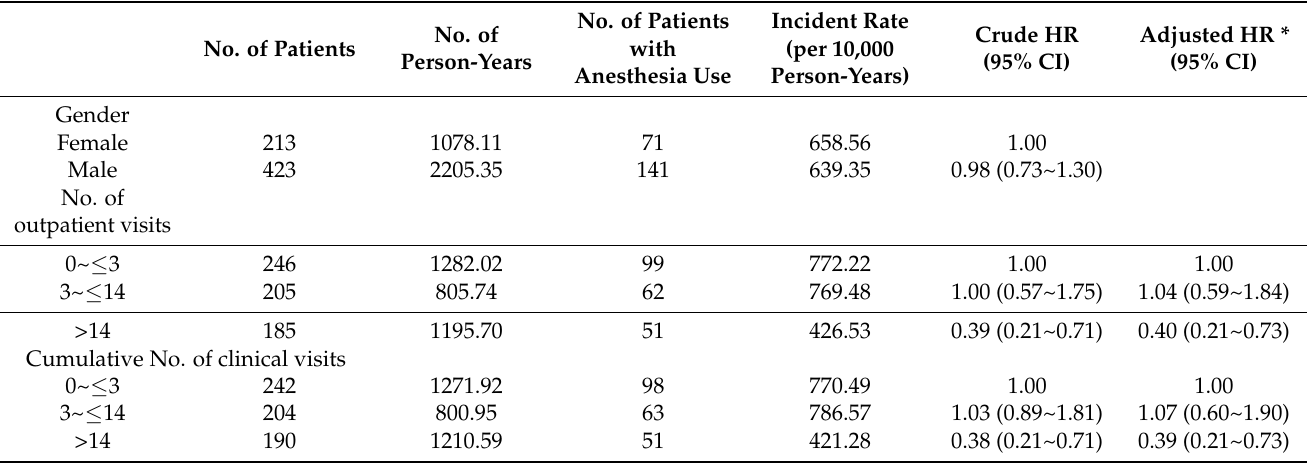
Table 3. Following clinical visit numbers in patients with asthma onset before general anesthesia (GA)